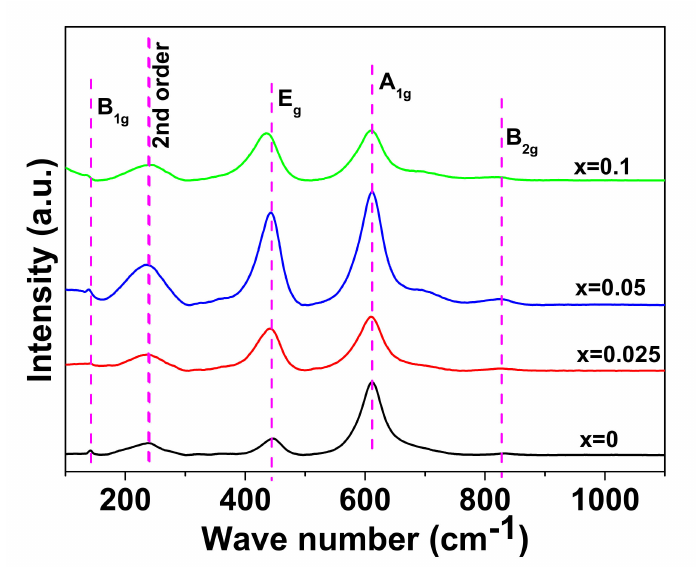
Figure 2. Raman spectra of the sintered ceramics of NSTO.